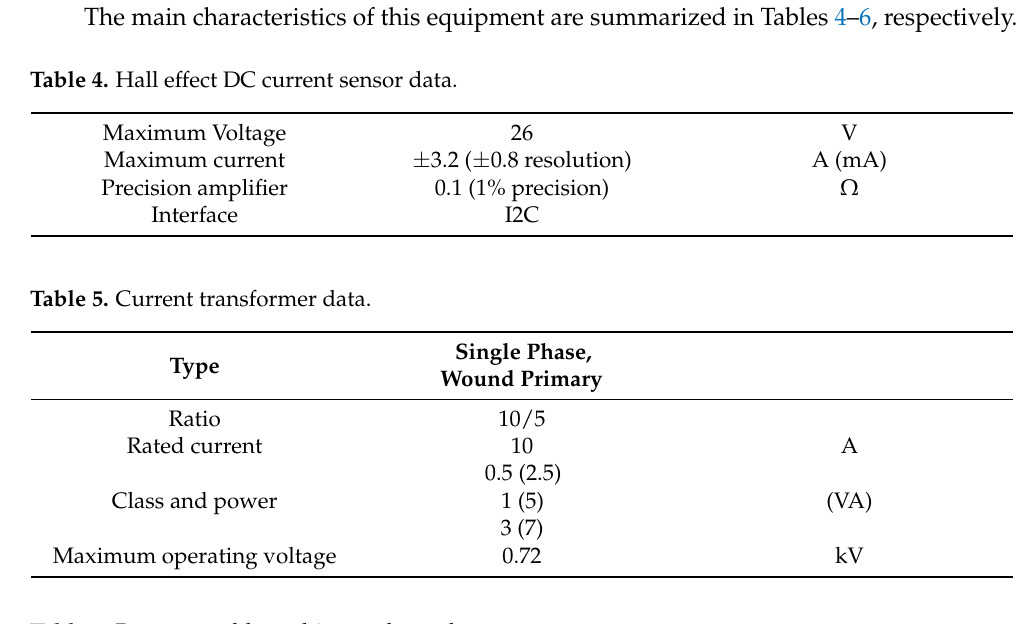
Table 6. Programmable multi-transducer